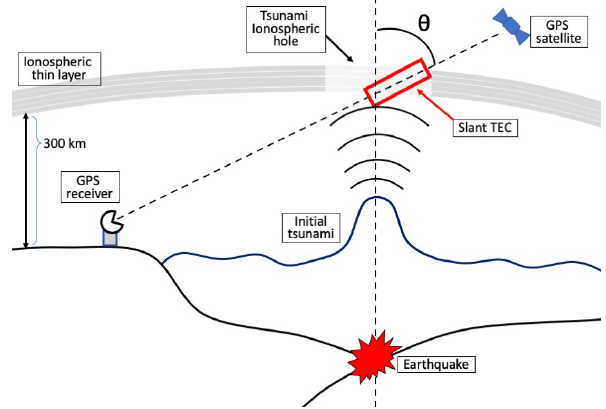
Figure 1. The schematic image of TEC depression detected by a satellite and a